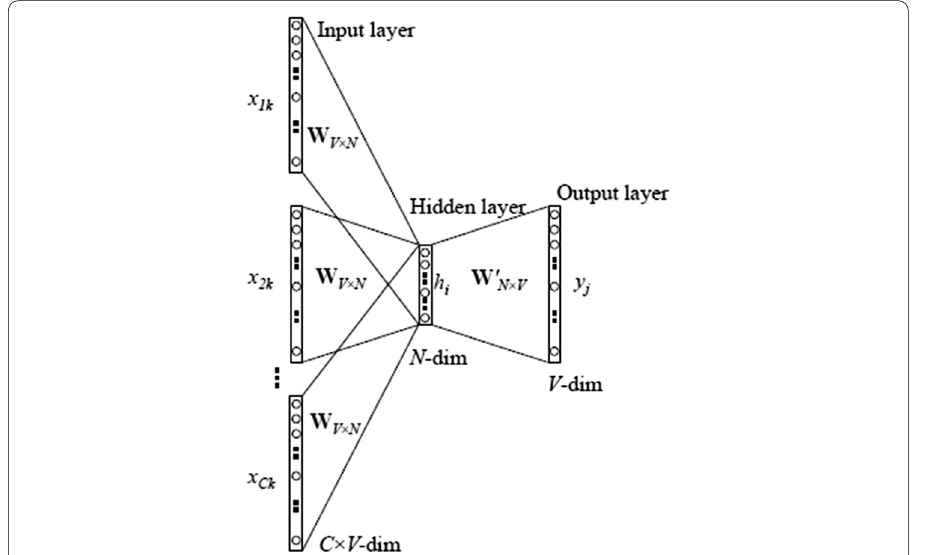
Fig. 12 Graphical representation of CBOW with C context words for target word at position k . Note The picture is taken from (Rong